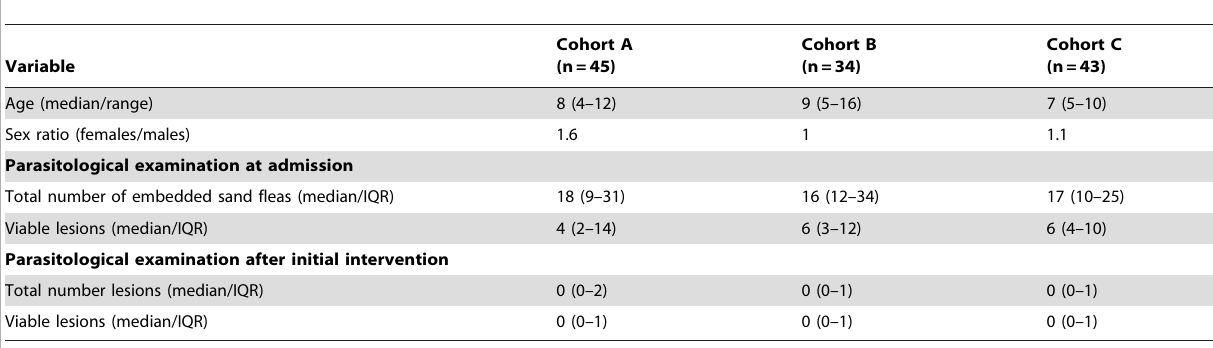
Table 1. Demographic and parasitological characteristics of the study population.